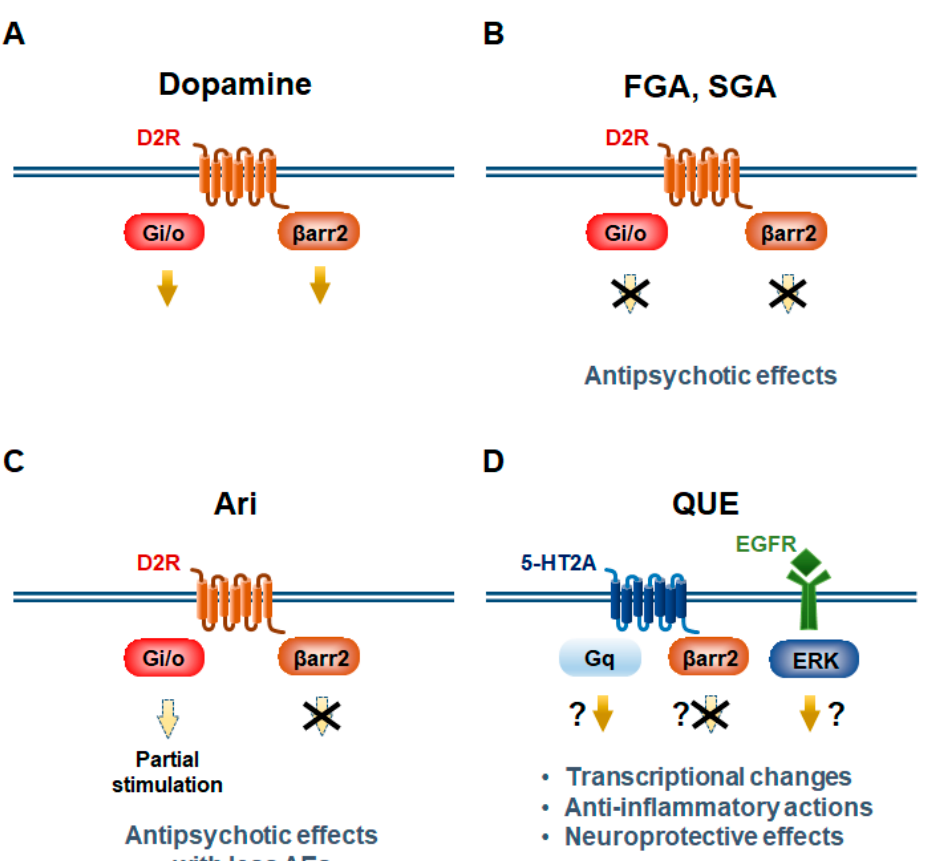
Figure 3. Proposed antipsychotic actions to confer bias of GPCR signaling. D2R-mediate Gi / o and β -arrestin2 ( β arr2) pathways in striatopallidal MSNs ( A – C ). First-generation (FGA) and second-generation antipsychotics (SGA) antagonize both of these two pathways ( B ). Aripiprazole (Ari) functions as a partial agonist / antagonist at D2R-Gi / o signaling, whereas it fully antagonizes D2R- β arr2 signaling ( C ). Quetiapine (QUE) blocks 5-HT2A- β arr2 signaling and activates 5-HT2A-Gq signaling. Quetiapine also activates epidermal growth factor receptor (EGFR)-ERK pathway ( D ).